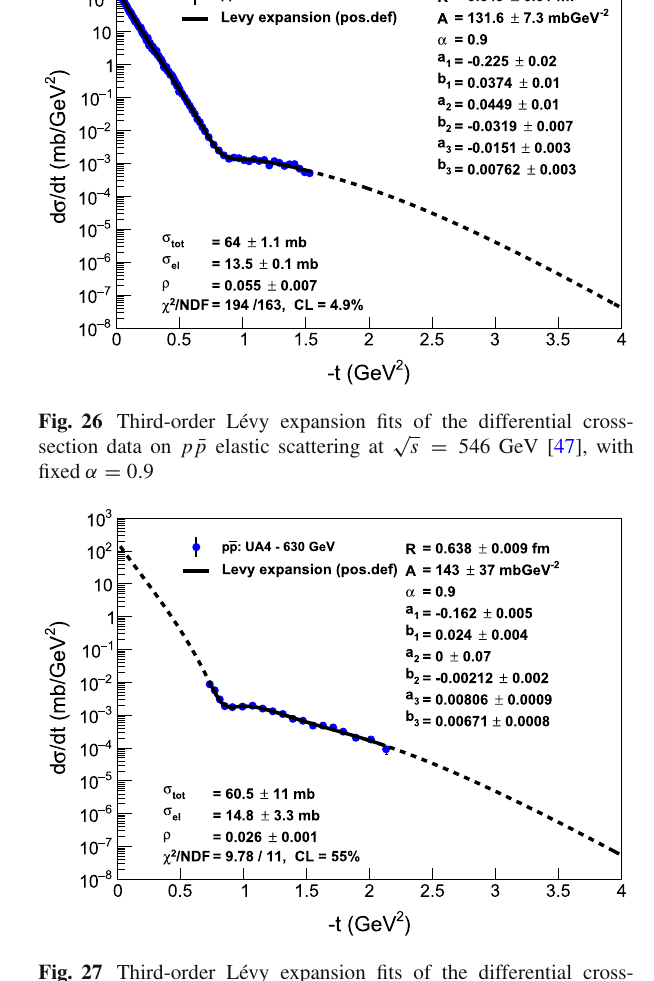
look quite reasonable to the naked eye, differ in their quality.